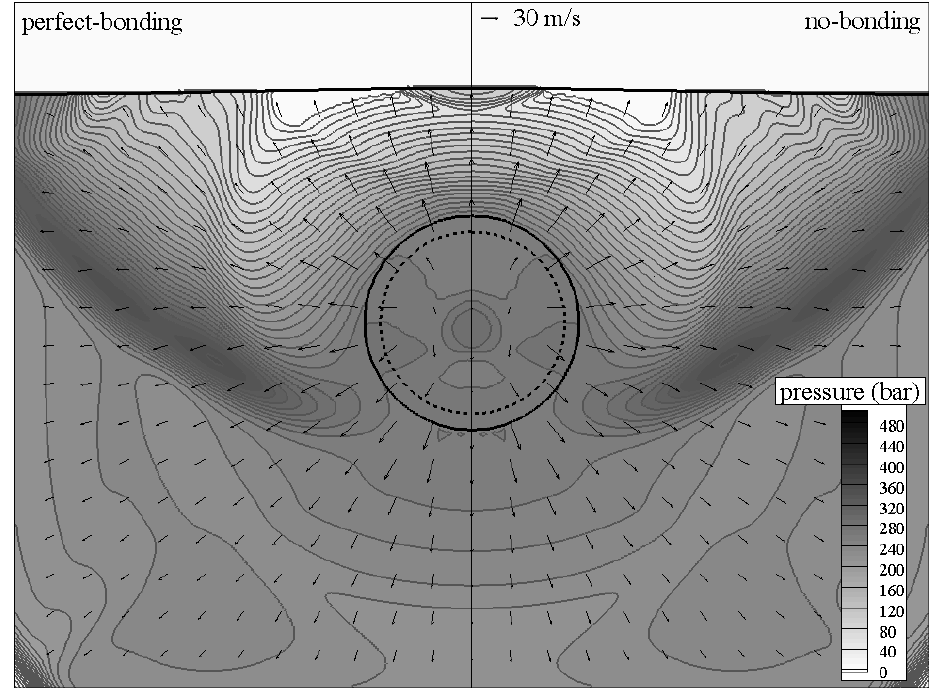
Fig. 12. Comparison of the fluid fields at t = 0 . 7 ms between the perfect- and no-bonding sandwich plates with clamped